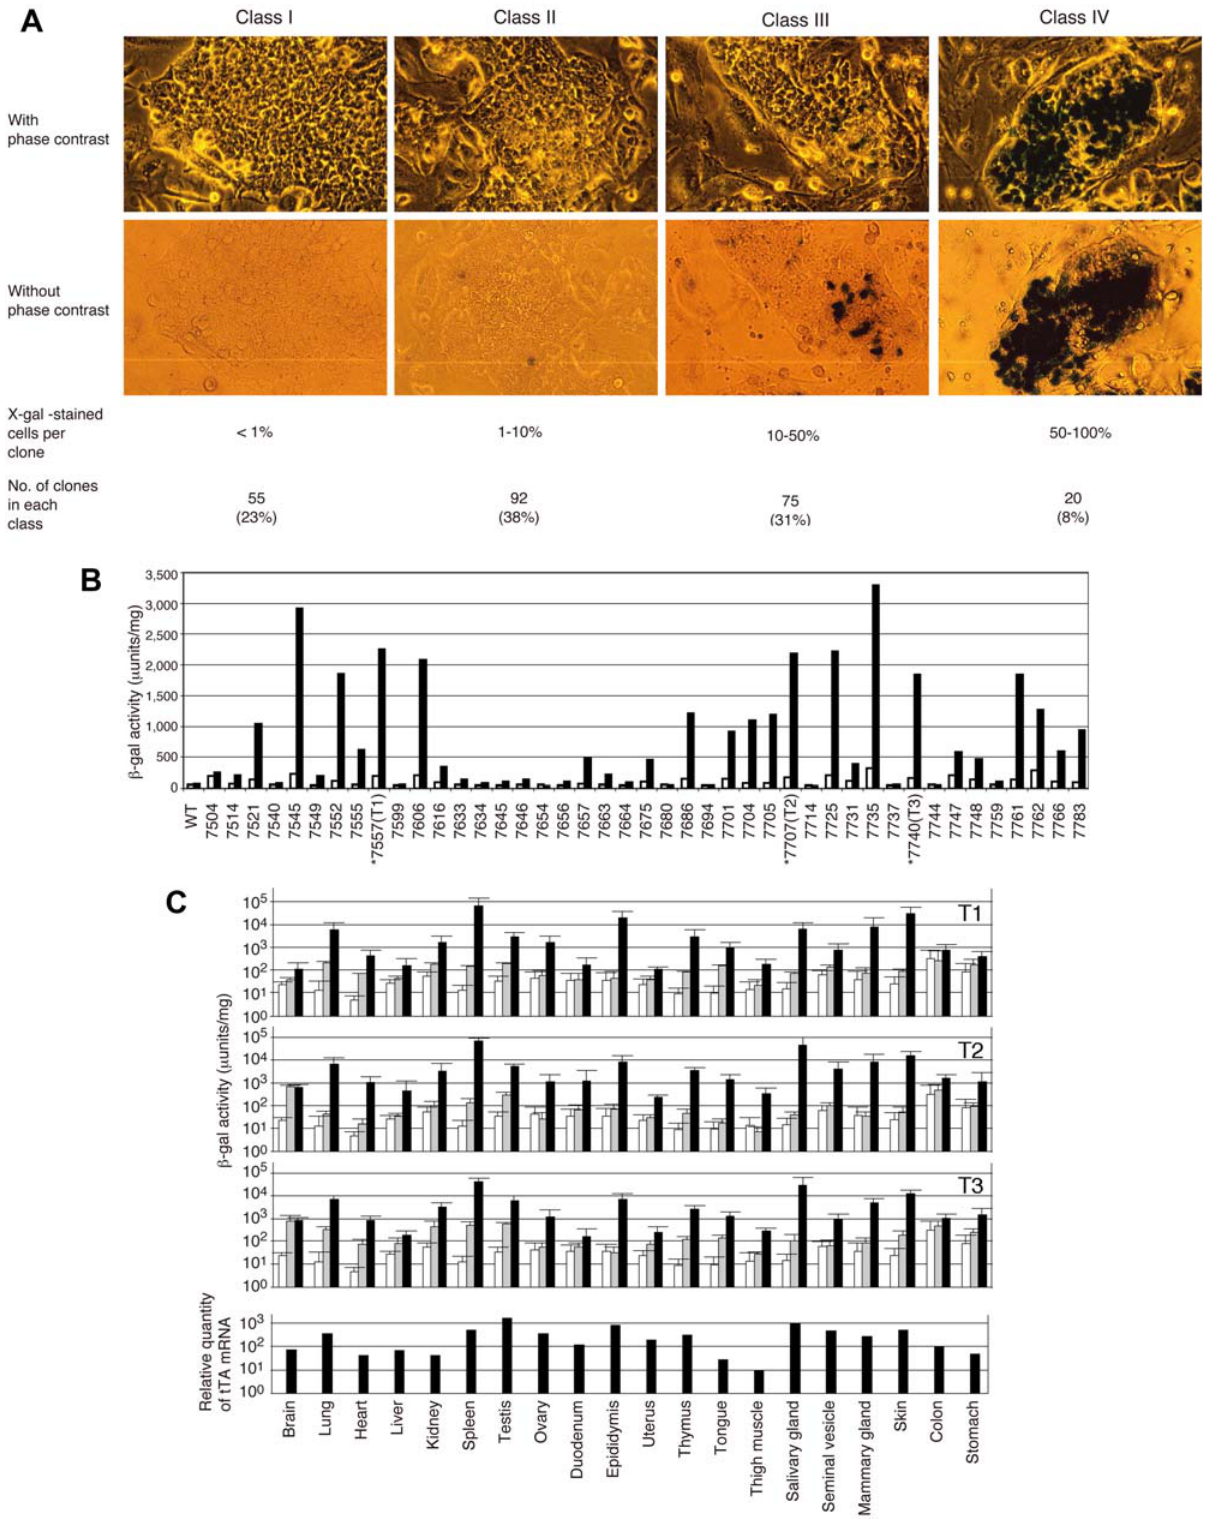
Figure 3. Characterization of gene regulation at TIGRE loci. (A) Screening for optimal integration sites in ES cells and classification of ES clones by X-gal staining. A representative ES clone is shown for each class with and without phase contrast for better imaging of ES cell morphology and X- gal staining, respectively. (B) Screening of class I clones for high inducibility. Forty three class I ES clones were transfected with a tTA expression vector and b -gal activity was quantified 48 hours post-transfection. Bars: open, without tTA; filled, with tTA. A luciferase expression vector was cotransfected to normalize b -gal activities. Three ES clones were designated as T1, T2 and T3 as shown in the figure, and were used to generate mice. (C) Gene regulation in mice generated from tightly regulated ES clones. Three mouse strains were established from ES clones T1, T2 and T3, and crossed to